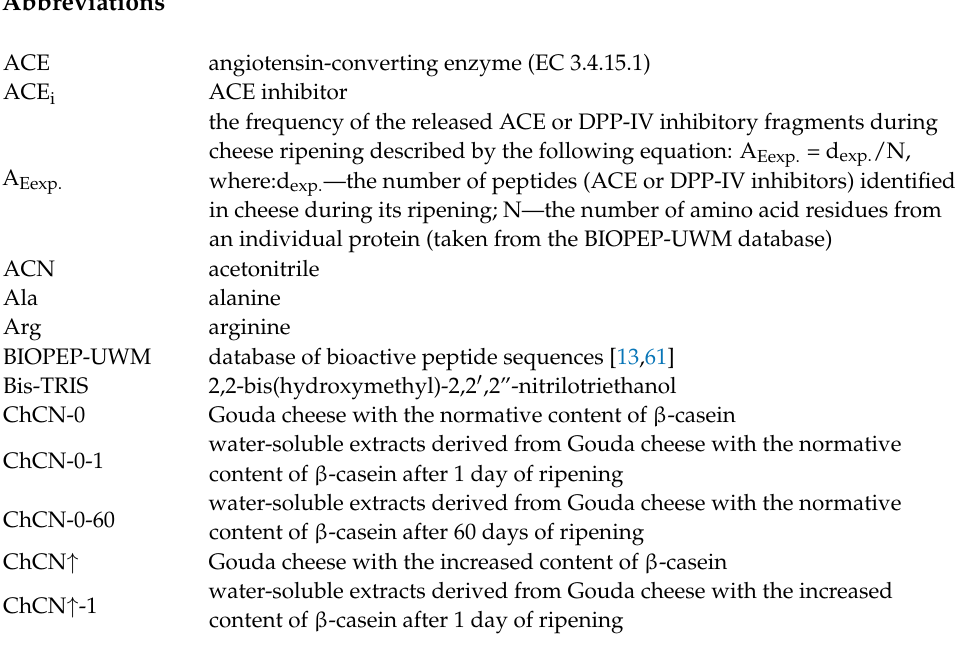
Table S2: RP-HPLC-MS/MS identification of peptides with ACE and/or DPP-IV-inhibitory activity in different Gouda cheese variants, Figure S1: RP-HPLC chromatograms of water-soluble extracts derived from Gouda cheese with modified β -casein content before and after ripening (1st and 60th day, respectively), within the time interval 1–10 min, Figure S2: RP-HPLC chromatograms of water- soluble extracts derived from Gouda cheese with modified β -casein content before and after ripening (1st and 60th day, respectively), within the time interval 10–60 min, Figures S3–S64: MS/MS spectra of